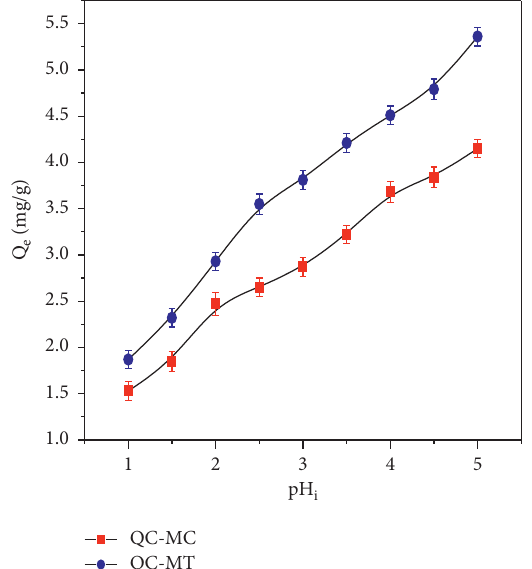
Figure 5: Effect of pH on Cd (II) removal by QC-MC and QC-MT ( C 0 � 10mg/L, V � 100mL, T � 25 ° C, m � 1.5g, and contact time � 45min for QC-MC and 30min for QC-MT).